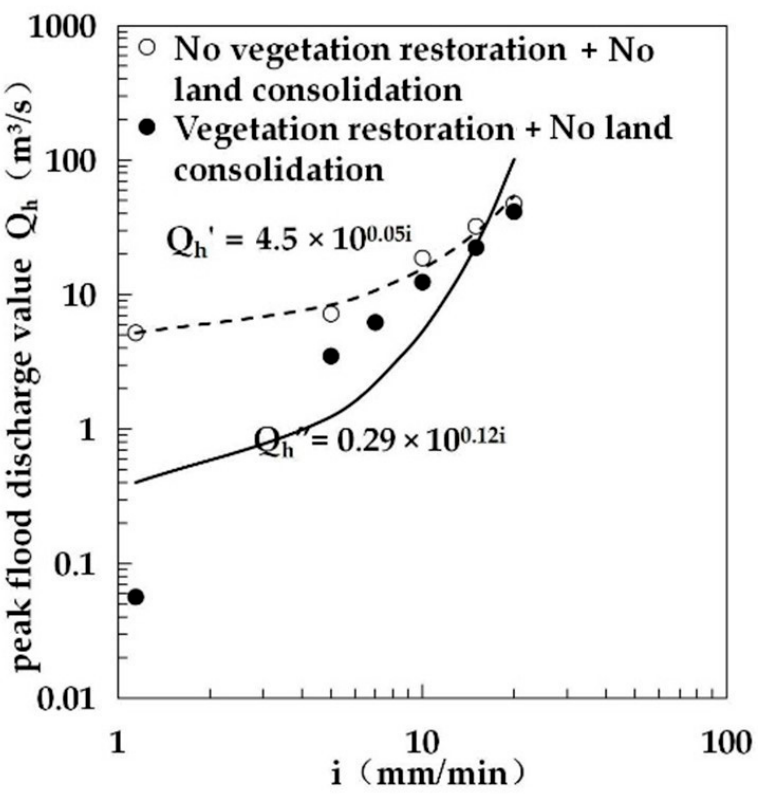
Figure 15. Changes in peak flood discharge value with rain intensity before and after vegetation restoration.